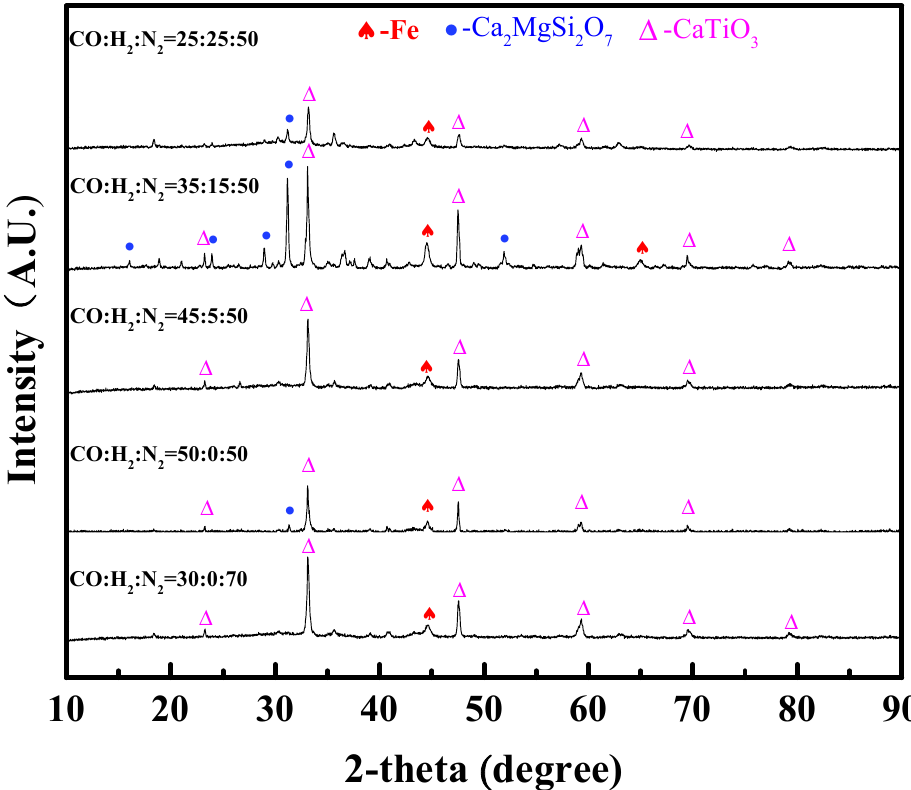
Figure 7. XRD patterns of the dripping slag with different contents of H 2 in reducing gas. In order to predict the behavior of ultimate slag, a pseudo-ternary phase diagram of CaO–SiO 2 –MgO(–Al 2 O 3 –TiO 2 ) was calculated by using FactSage 8.0. The results are plotted in Figure 8. The contents of TiO 2 and Al 2 O 3 were set at 23.65 wt% and 11.58 wt%, assuming that iron oxides of VTM sinter were completely reduced to metallic iron. Spot O 1 located the composition of the slag by neglecting iron and other minuscule components. If the slag was molten and uniform when the temperature was increased to above T d , the slag would crystallize from O 1 to O 2 by precipitating perovskite (CaTiO 3 ) during the cooling process. Perovskite was observed in all the XRD patterns, which may be due to the fact that it has already been formed in the sinter. Then, CaTiO 3 and Mg 2 SiO 4 were co-crystallized after reaching spot O 2 , and the liquid phase line moved from O 2 to O 3 . However, Mg 2 SiO 4 was not observed in the XRD patterns, since the dripped slag was quenched in oil. Spot O 3 is a ternary eutectic point, at which Mg 2 SiO 4 , CaTiO 3 and CaAl 2 Si 2 O 8 were co-crystallized. The diffraction peaks of Ca 2 MgSi 2 O 7 rather than CaAl 2 Si 2 O 8 were observed in the XRD patterns. The difference between the actual slag phases and theoretical analysis may be influenced by dynamic factors and ununiform state during the crystallization